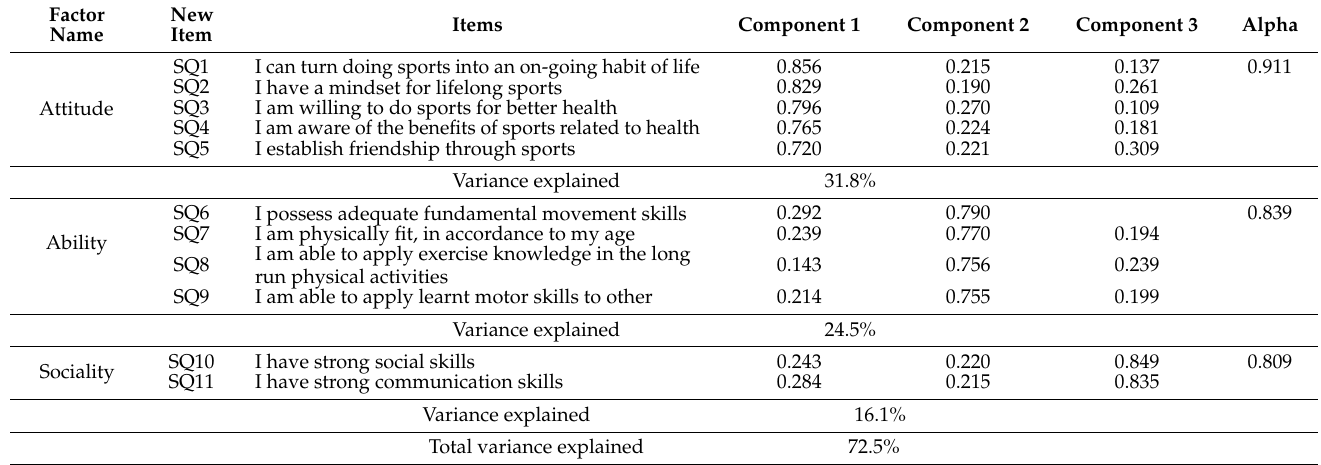
Table 4. Factor structures by exploratory factor analysis ( n =